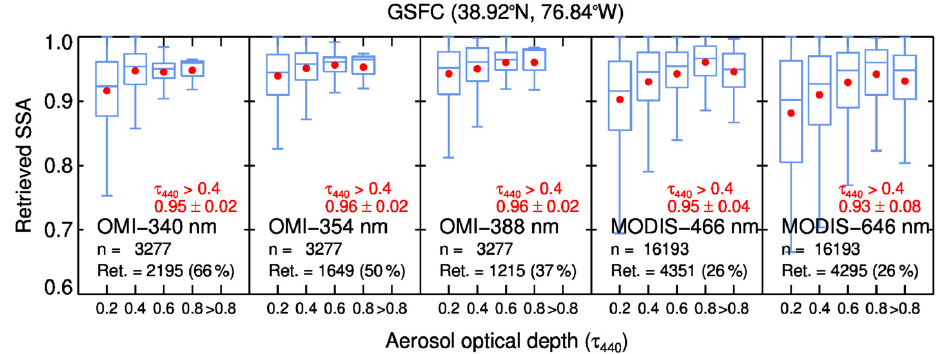
Figure 4. Retrieved aerosol SSA over the GSFC site for the satellite observation period of 2005–2016. Average and standard deviation of retrieved SSA for the observations with τ 440 > 0 . 4 are shown in red. n is the number of satellite–AERONET collocated observations and “ret.” is the number of observations for which SSA is